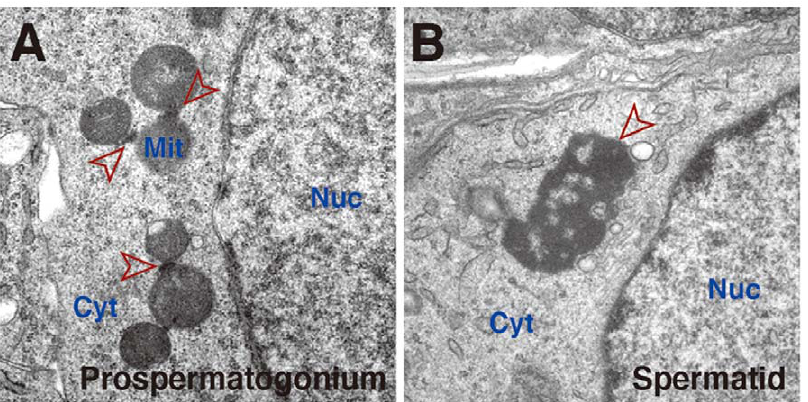
Figure 1. Germinal granules/nuage in mouse germ cells. Electron microscopy of a fetal prospermatogonium (A) and postnatal spermatid (B). In (A), inter-mitochondrial cement structures are seen as fine electron-dense material among mitochondria (arrowheads). Inter-mitochondrial cement is also seen in postnatal spermatogonia, spermatocytes and in growing oocytes. In (B), a chromatoid body (arrowhead), a specialized form of germinal granules/nuage, is seen in the cytoplasm independently of mitochondria. Chromatoid bodies are much larger in size than inter-mitochondrial cement and are observed mostly as one or two solitary aggregates in haploid spermatids. Both inter-mitochondrial cement and chromatoid bodies contain piwi-pathway components. Nuc, nucleus; Cyt, cytoplasm; Mit,